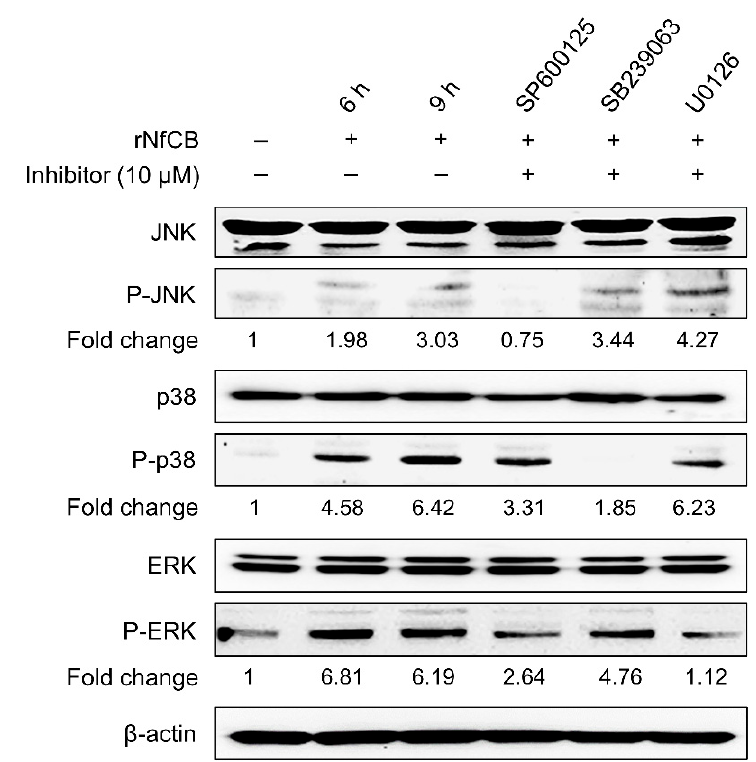
Figure 5. Phosphorylation levels of JNK, p38, and ERK in rNfCB-stimulated BV-2 microglial cells. To analyze phosphorylation levels of MAPKs, BV-2 microglial cells were pre-treated with JNK, p38, or ERK inhibitor, followed by treatment with rNfCB (100 µg/mL). Total proteins were extracted from the cells, and phosphorylation levels of JNK, p38, and ERK were analyzed via immunoblot using a specific antibody for each protein. The total JNK, p38, ERK, and β -actin were used as internal controls. Fold-change means relative density change compared to negative control without treatment with rNfCB and treatment with rNfCB and inhibitor.